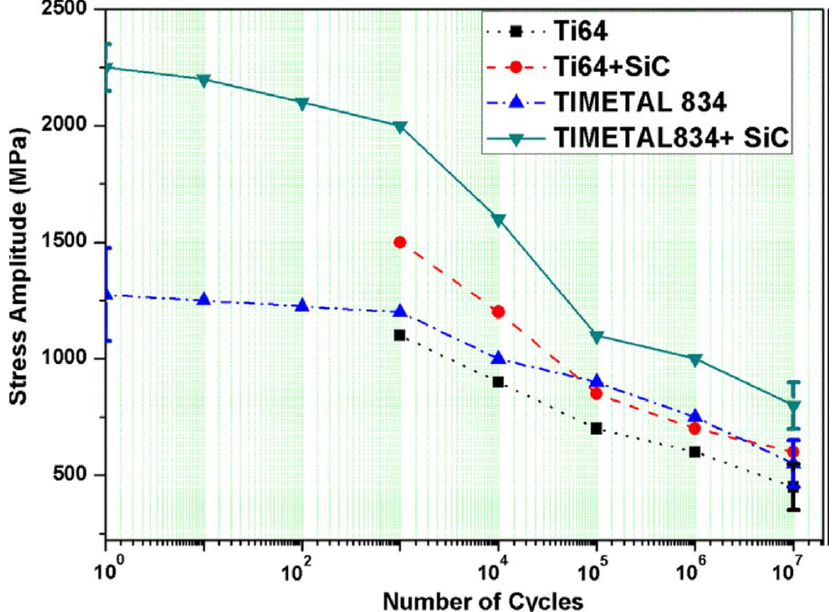
Figure 7. Fatigue behaviour of SiC fiber-reinforced TMCs